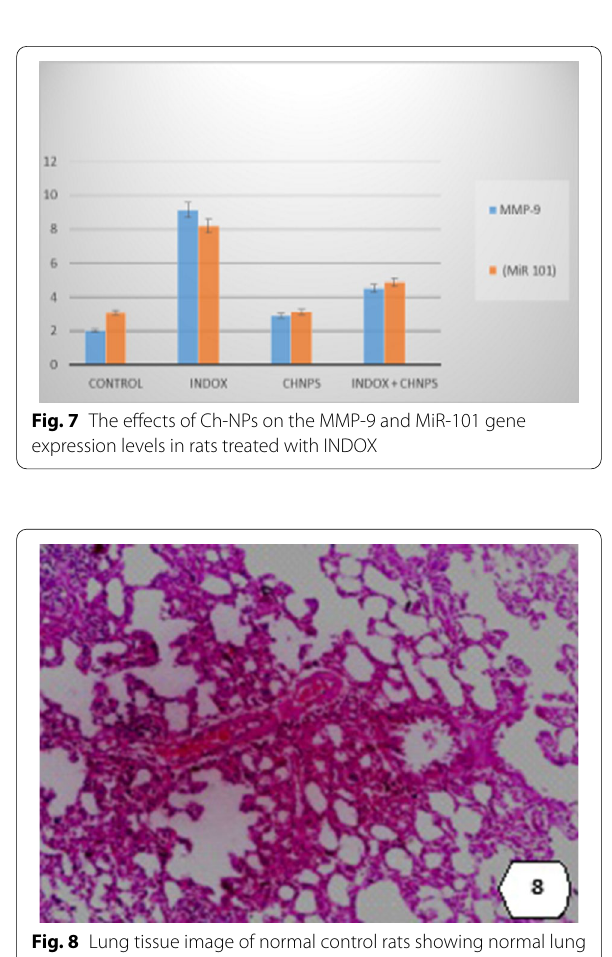
100 magnification) ×